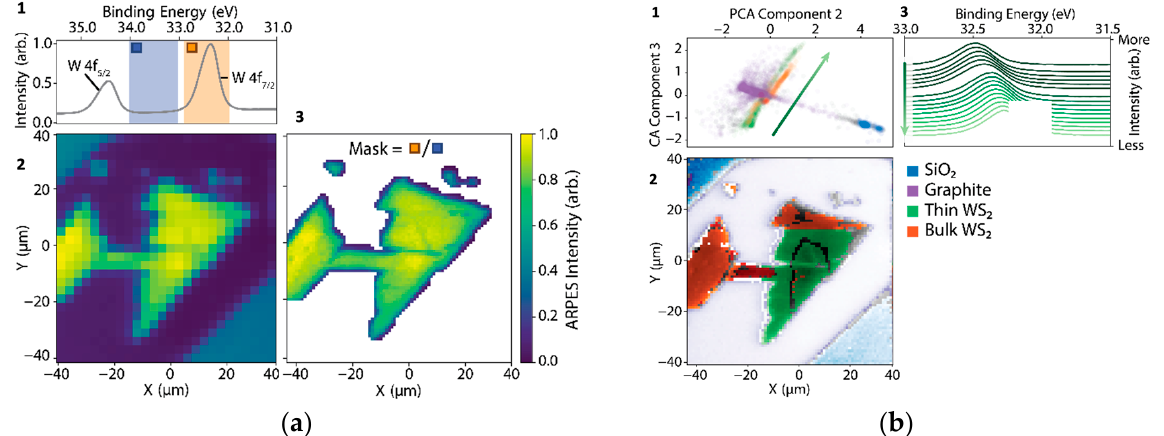
Figure 3. nanoARPES Opportunities for Analysis-Driven Acquisition. ( a1 ) Tungsten 4f core-level X-ray photoelectron spectrum at a specific location ( a2 ) Tungsten 4f core-level X-ray photoelectron spectrum as a function of position ( a3 ) Tungsten 4f core-level X-ray photoelectron spectrum at binding energy shown in the blue and orange areas of ( a1 ). ( b1 ) Coarse nanoXPS image providing sample topography, with complex region-of-interest. ( b2 ) High-resolution experiment trajectory on sample regions with intense W 4f peak (blue divided by orange energy region). Collected area occupies 37% of total scan window. ( b1 – b3 ) Integrating machine learning into the analysis–acquisition loop permits rapid understanding of the sample morphology and efficient use of acquisition time. ( b1 ) PCA component projection for XPS curves across the sample surface colored according to their composition (labels at right of ( b3 )). ( b2 ) Spatial map of all XPS curves across the sample corresponding to scattered points in ( b2 ) showing correspondence to distinct physical regions on the sample. ( b3 ) W 4 f 7/2 level green WS 2 multilayer region of the sample corresponding to spatial cohorts with varying PCA components (green arrow in ( b2 )). Even coarse decompositions such as PCA map onto physically interpretable qualities such as inhomogeneous doping across the sample surface inducing shifts in the peak locations seen by nanoXPS.